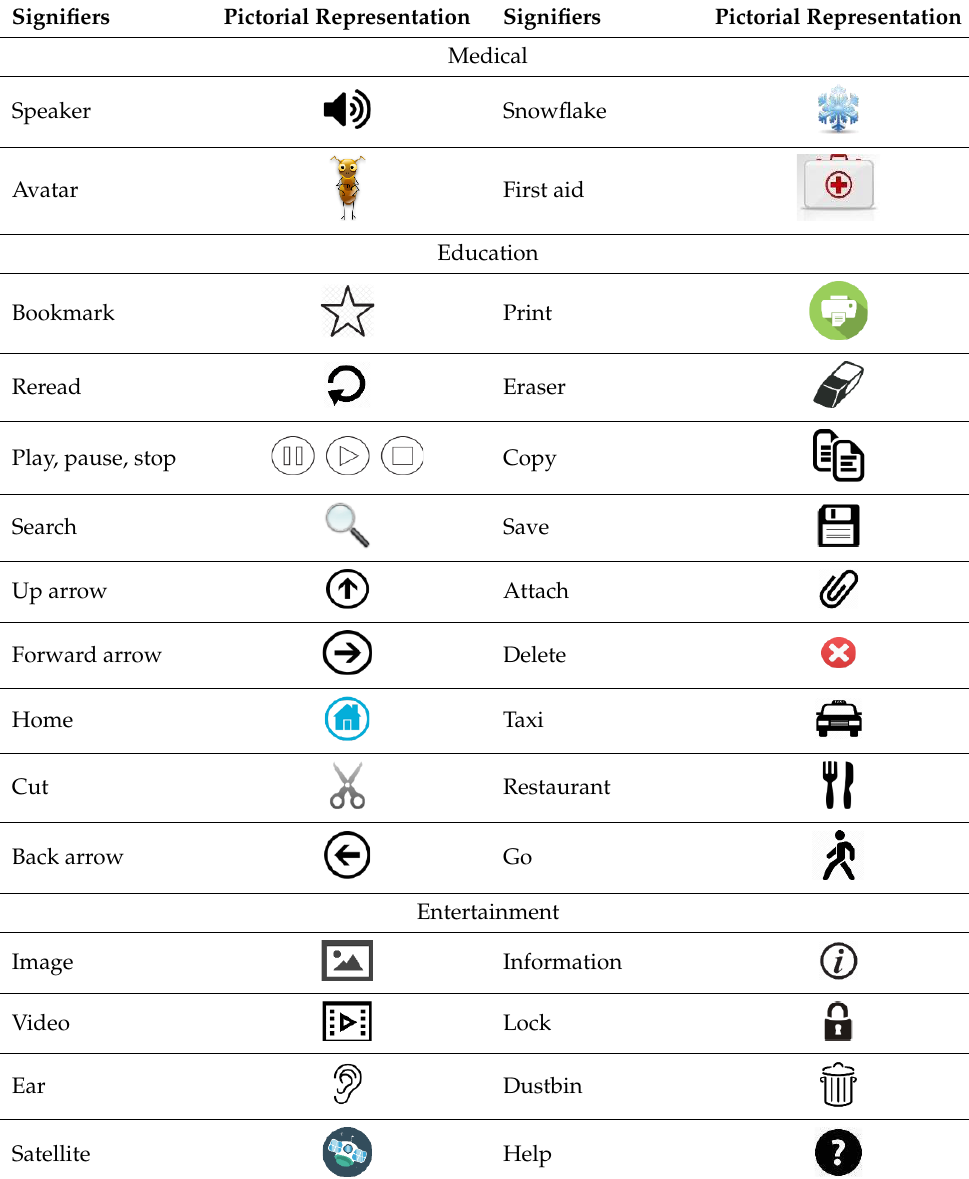
Table 3. Pictorial representation to represent icon buttons.